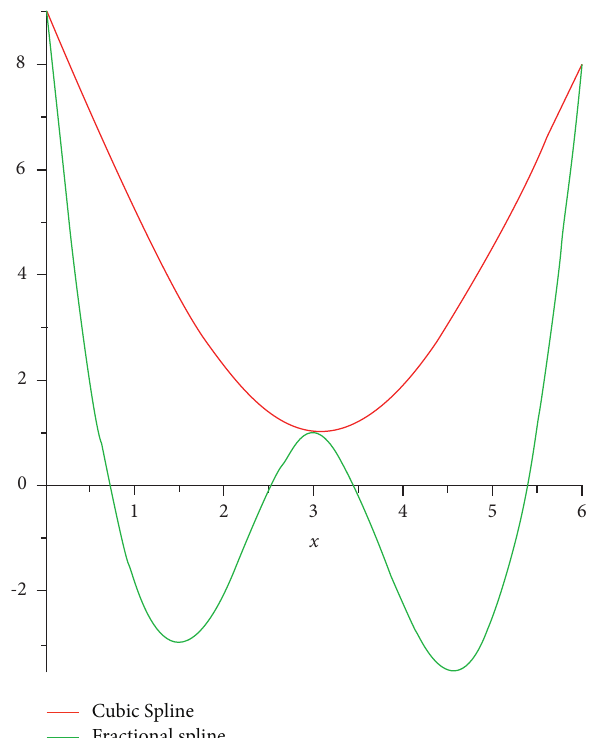
Figure 15: Piecewise curves can be manipulated by the choice of shape parameters 3.